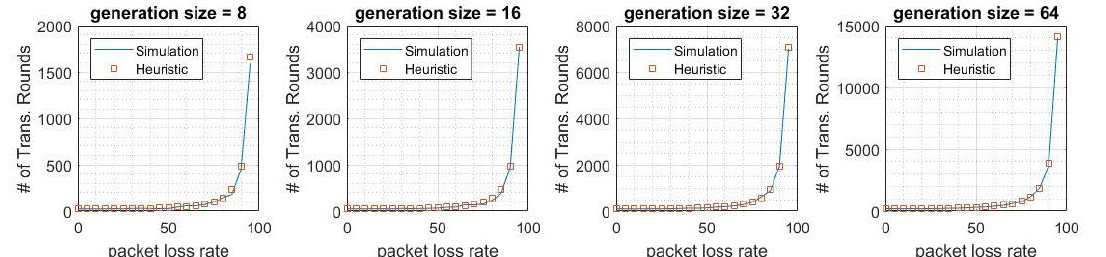
Figure 3. Average number of transmissions in all links in source coding.